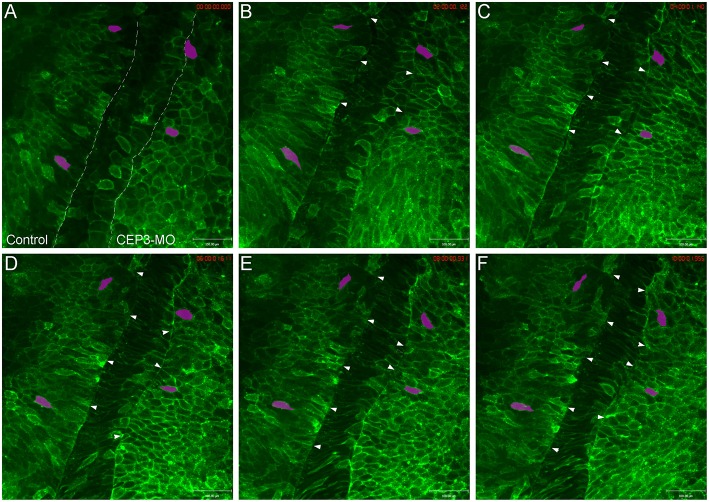
Loss of Cdc42ep3 disrupted somite segmentation and cell shape changes. Wilson explants were dissected from embryos receiving membrane-tethered EGFP (EGFP-CAAX) on one side, and CEP3-MO plus EGFP-CAAX on the other side, and the segmentation process was followed by time-lapse microscopy. (A–F) Time frames at 2-h intervals. The dashed lines in (A) marks the boundaries between pre-somitic mesoderm and the notochord. Arrowheads marked segmentation furrows. Two cells on each side of the explant were followed by magenta shade. CEP3-MO not only impaired somite segmentation, but also affected the mediolateral elongation of cells. Scale bar = 100 μm.